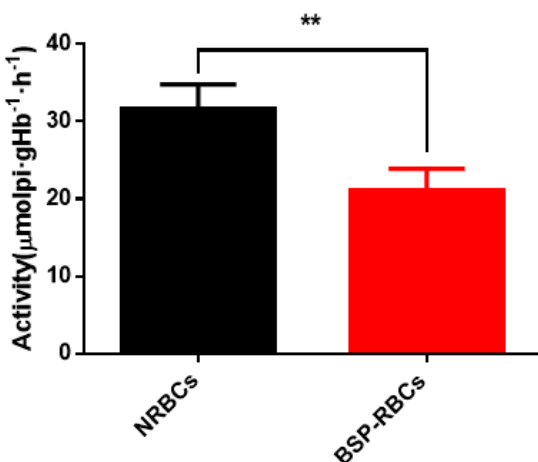
Figure 4. Na + /K + -ATPase activity on membrane of NRBCs and BSP-RBCs. Data are represented as mean ± SD, three samples were used in each group. ** correspond to p ＜ 0.01.